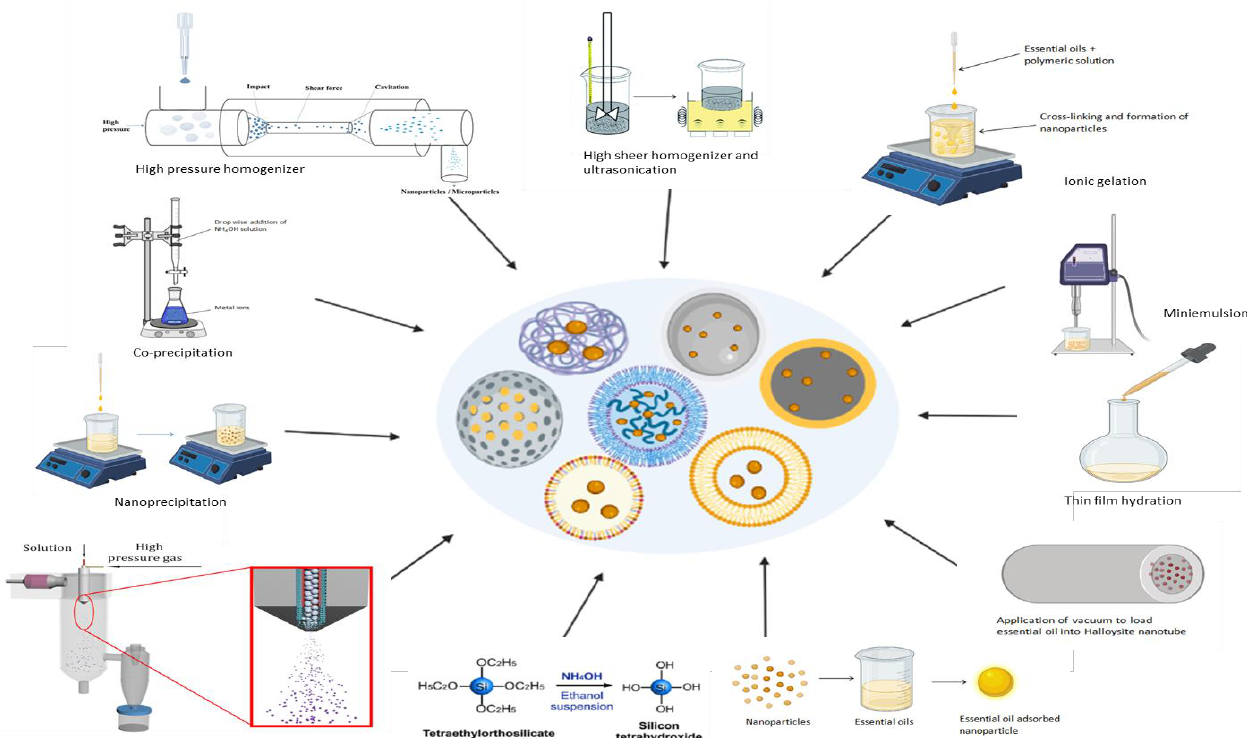
Figure 3. Synthetic methods for nanoparticles.